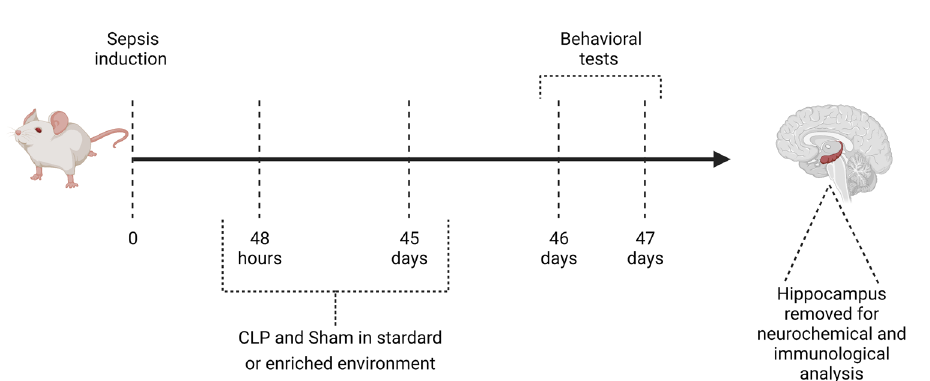
Figure 3. Timeline of the second experiment, date of sepsis induction, behavioral tests and structure removed for analysis. The animals were placed in cages at the university vivarium for behavioral